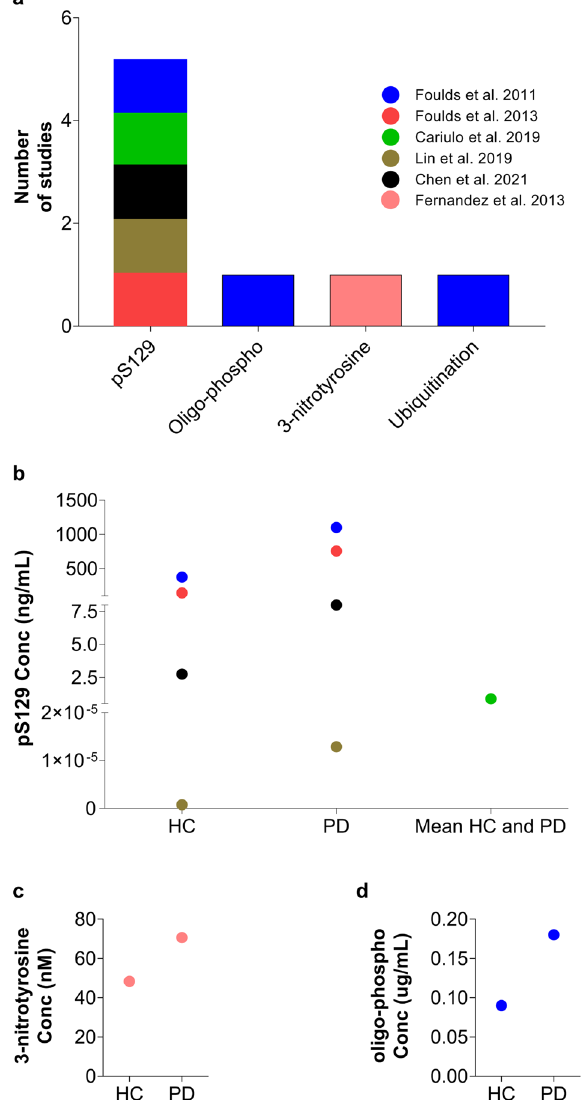
Fig. 5 aSyn PTMs in Plasma/Serum. a Numbers of studies that reported the detection of aSyn PTMs in plasma/serum. b Variability of pS129 concentration between HC and PD in the different studies. Each dot represents the mean concentration of pS129 aSyn reported in each study. The mean of HC and PD is displayed for Cariulo et al. 53 because only one pS129 level was provided in that study. Other aSyn PTMs, namely, c serum 3-nitrotyrosine 145 and d plasma oligo- phosphorylation 54 , were also reported, but only in a single study. Ubiquitinated aSyn levels are not shown because this modi fi cation was assessed and quanti fi ed only by WB. The legend/color code in a corresponds also to b , c and d